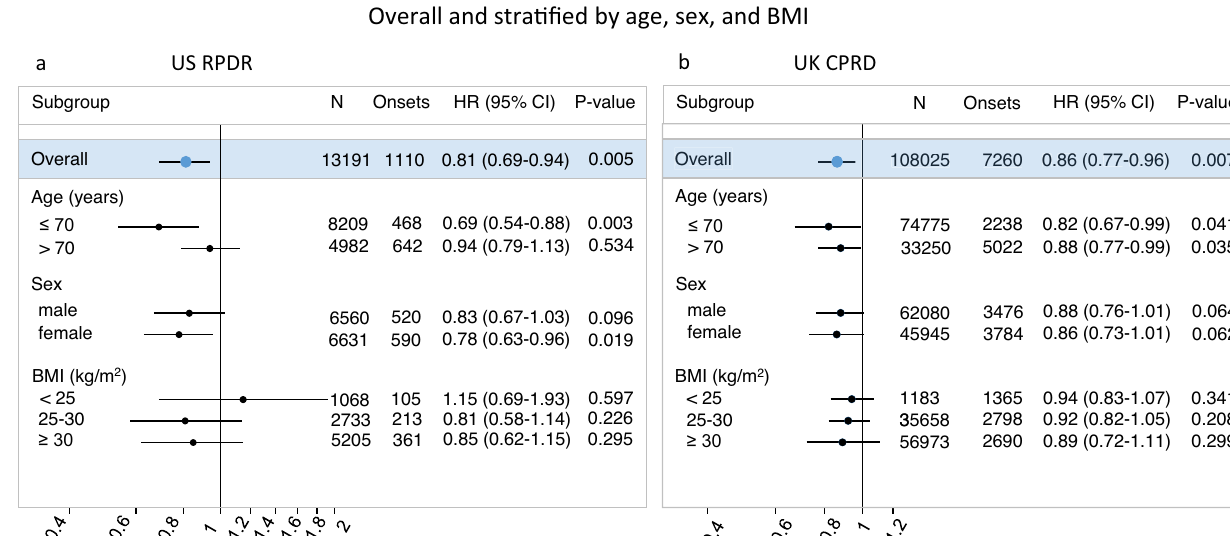
Fig. 3 | Metformin reduces incident dementia relative to sulfonylureas in type 2-diabetic patients aged >50 years at treatment initiation. HRs were estimated using the Cox PH model for the cause-speci fi c hazards of dementia, with only treatment as a covariate and baseline covariate distributions between treatment armsbalanced by IPTW. a , b Forest plots present HRs overalland strati fi ed by age, sex, and BMI level at baseline, with sulfonylureas as the reference group. N =# of